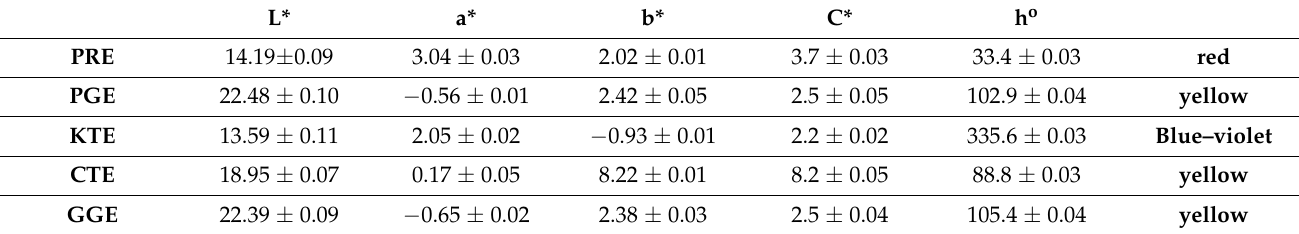
Table 3. Color parameters for water–ethanol extracts (concentration of 100 mg/mL): P. rhoeas L. (PRE), P. granatum L. (PGE) , C. ternatea L. (KTE), C. tinctorius L. (CTE) , G. globasa L. (GGE). Values are means of three replicate determinations ( n = 3) ± SD.